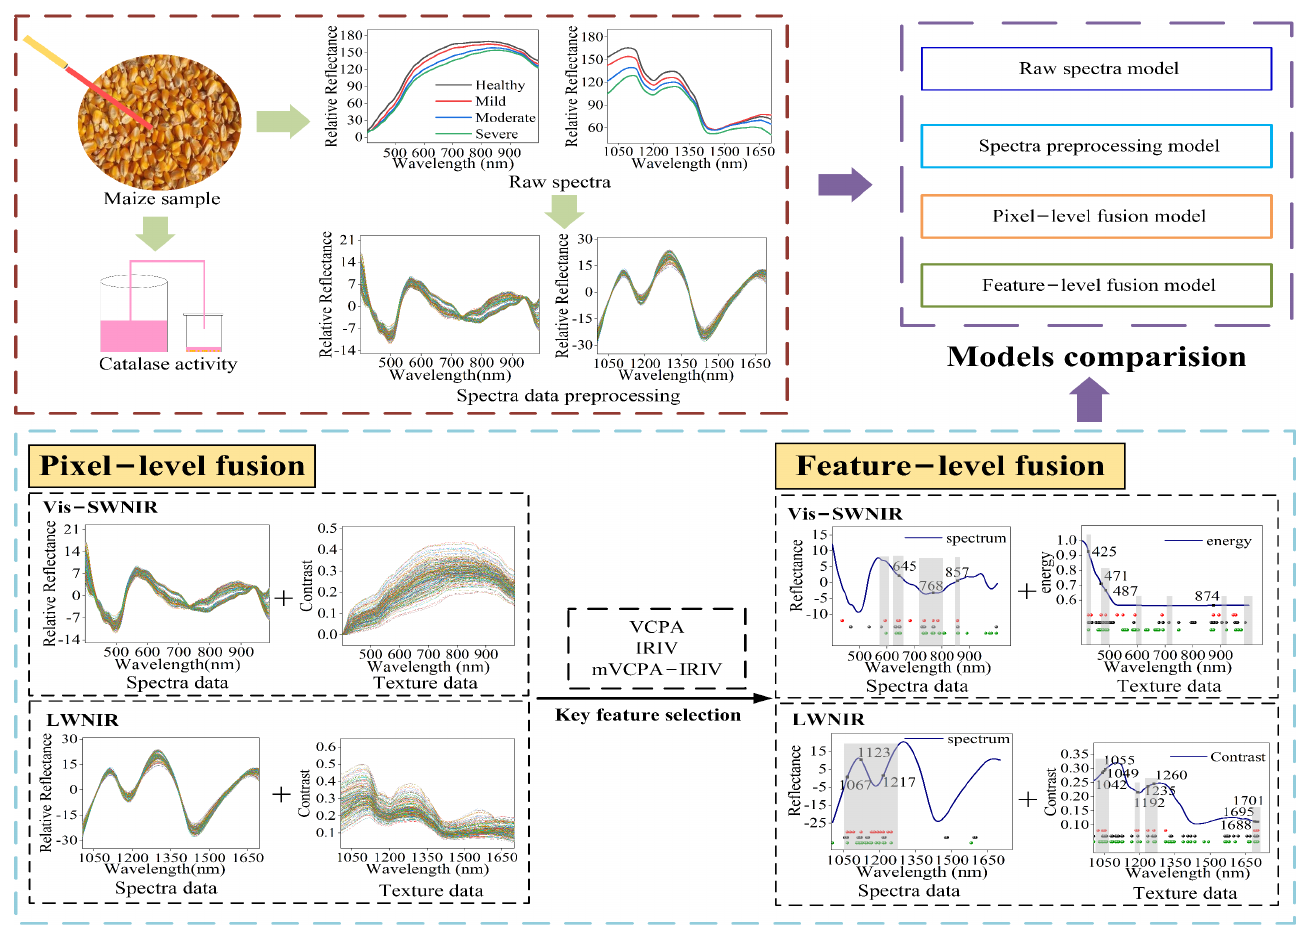
Figure 3. The experimental scheme of the data fusion model for identification of maize with different moldy levels.